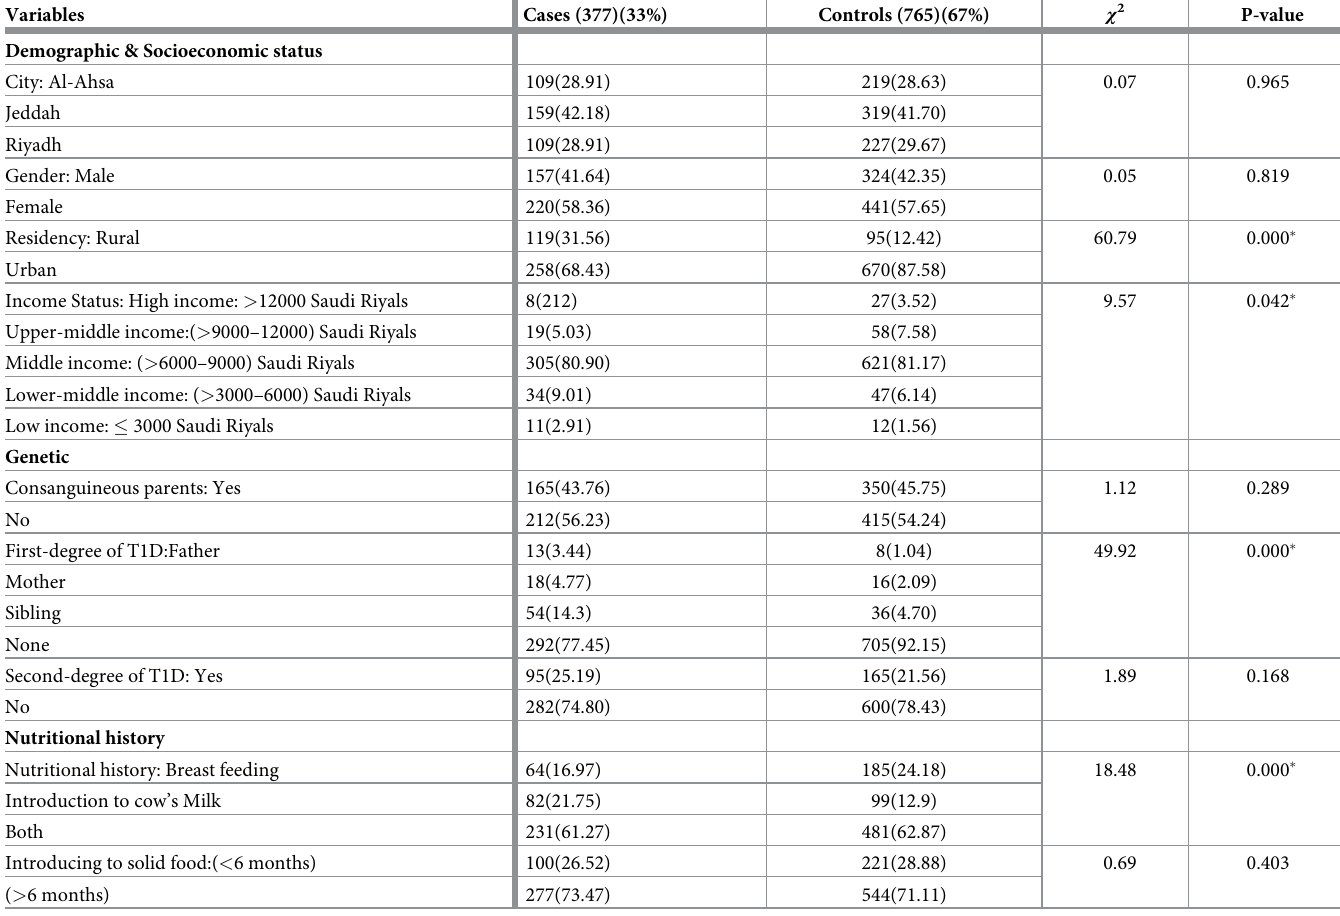
Table 1. Characteristics of the study cohort for demographic, genetic, and nutritional history together with their corresponding frequency count and percentage for case and control groups. The hypothesis test results from a chi-square test of homogeneity in the distribution of categorical variables between the two groups together with their corresponding p-value are also presented. The significance level was set at α = 0.05, with statistically significant differences highlighted with an asterisk ( � ). Variables Cases (377)(33%) Controls (765)(67%) χ 2